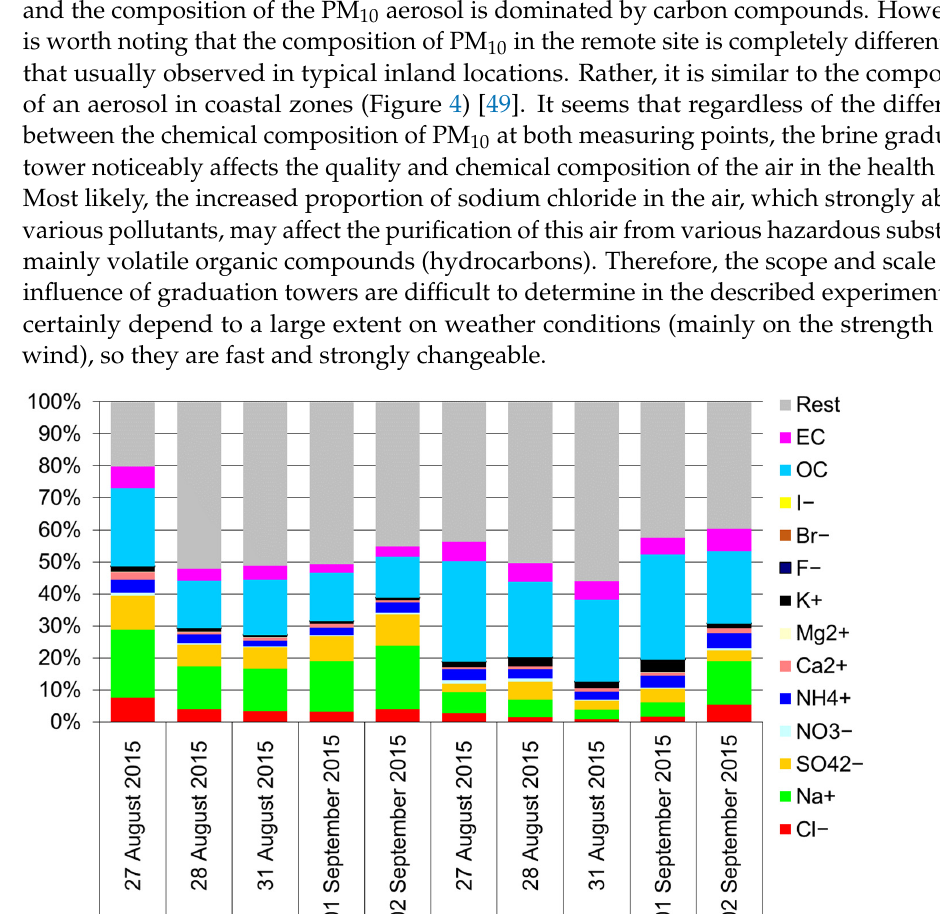
Figure 4. Chemical composition of an aerosol in various locations (inland and in coastal zones) [49] and in the Wieliczka Salt Mine (last four columns: grad. tower TSP, remote site TSP, grad. tower PM 10 ; remote site PM 10 ). The described impact of the graduation towers on air quality, apart from its immedi- ate surroundings, is also visible in the case of the chemical composition of TSP (Figure 2). A clear share of chlorides and sodium and a very small share of carbon compounds and nitrates in TSP clearly distinguishes the aerosol in the salt mine from a typical urban aer- osol in the southern part of Poland [40,47–49]. The determined components of TSP in the graduation tower constituted a very small part of its mass; on average, about 10% during the research period. Chlorides and sodium make up most of these components. Since the